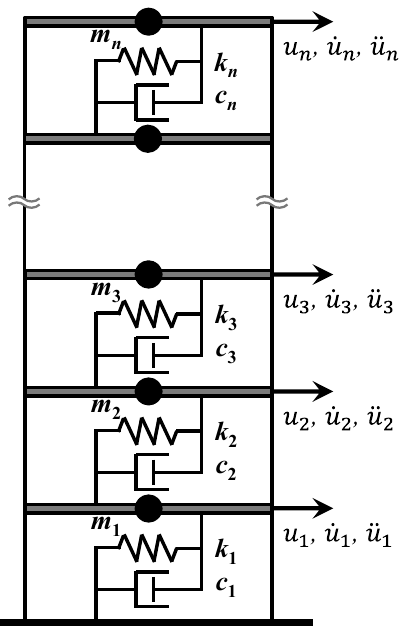
Figure 4. Schematic view of a shear building. Table 1. Calculated peak relative displacements and occurrence-times without considering damage.